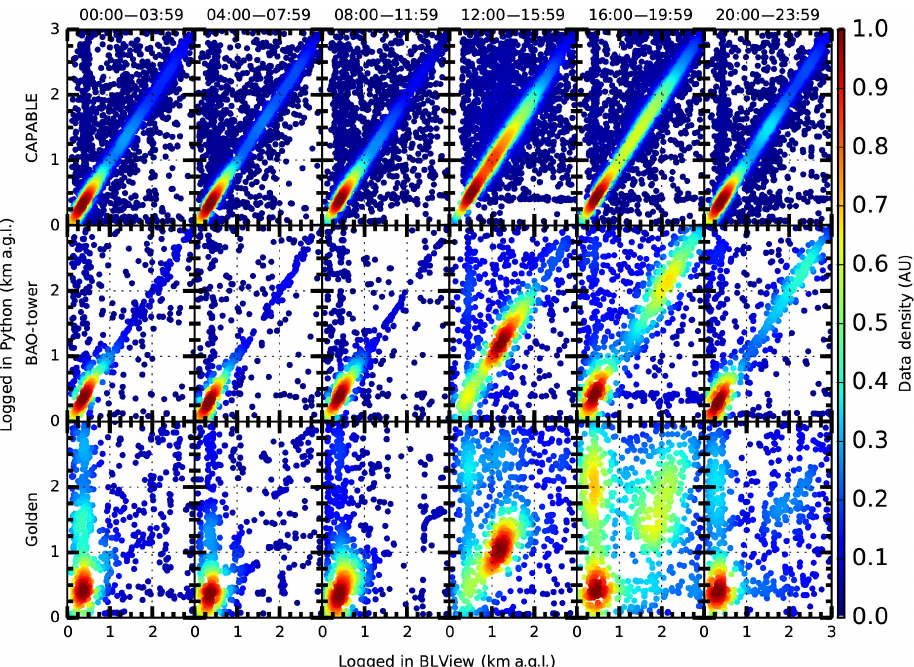
Figure 6. Correlation plots for data collected at the three sites under study. Data density is presented to better understand the distribution within the scatter plots. Data were averaged to 5min resolution, without application of filtering criteria.